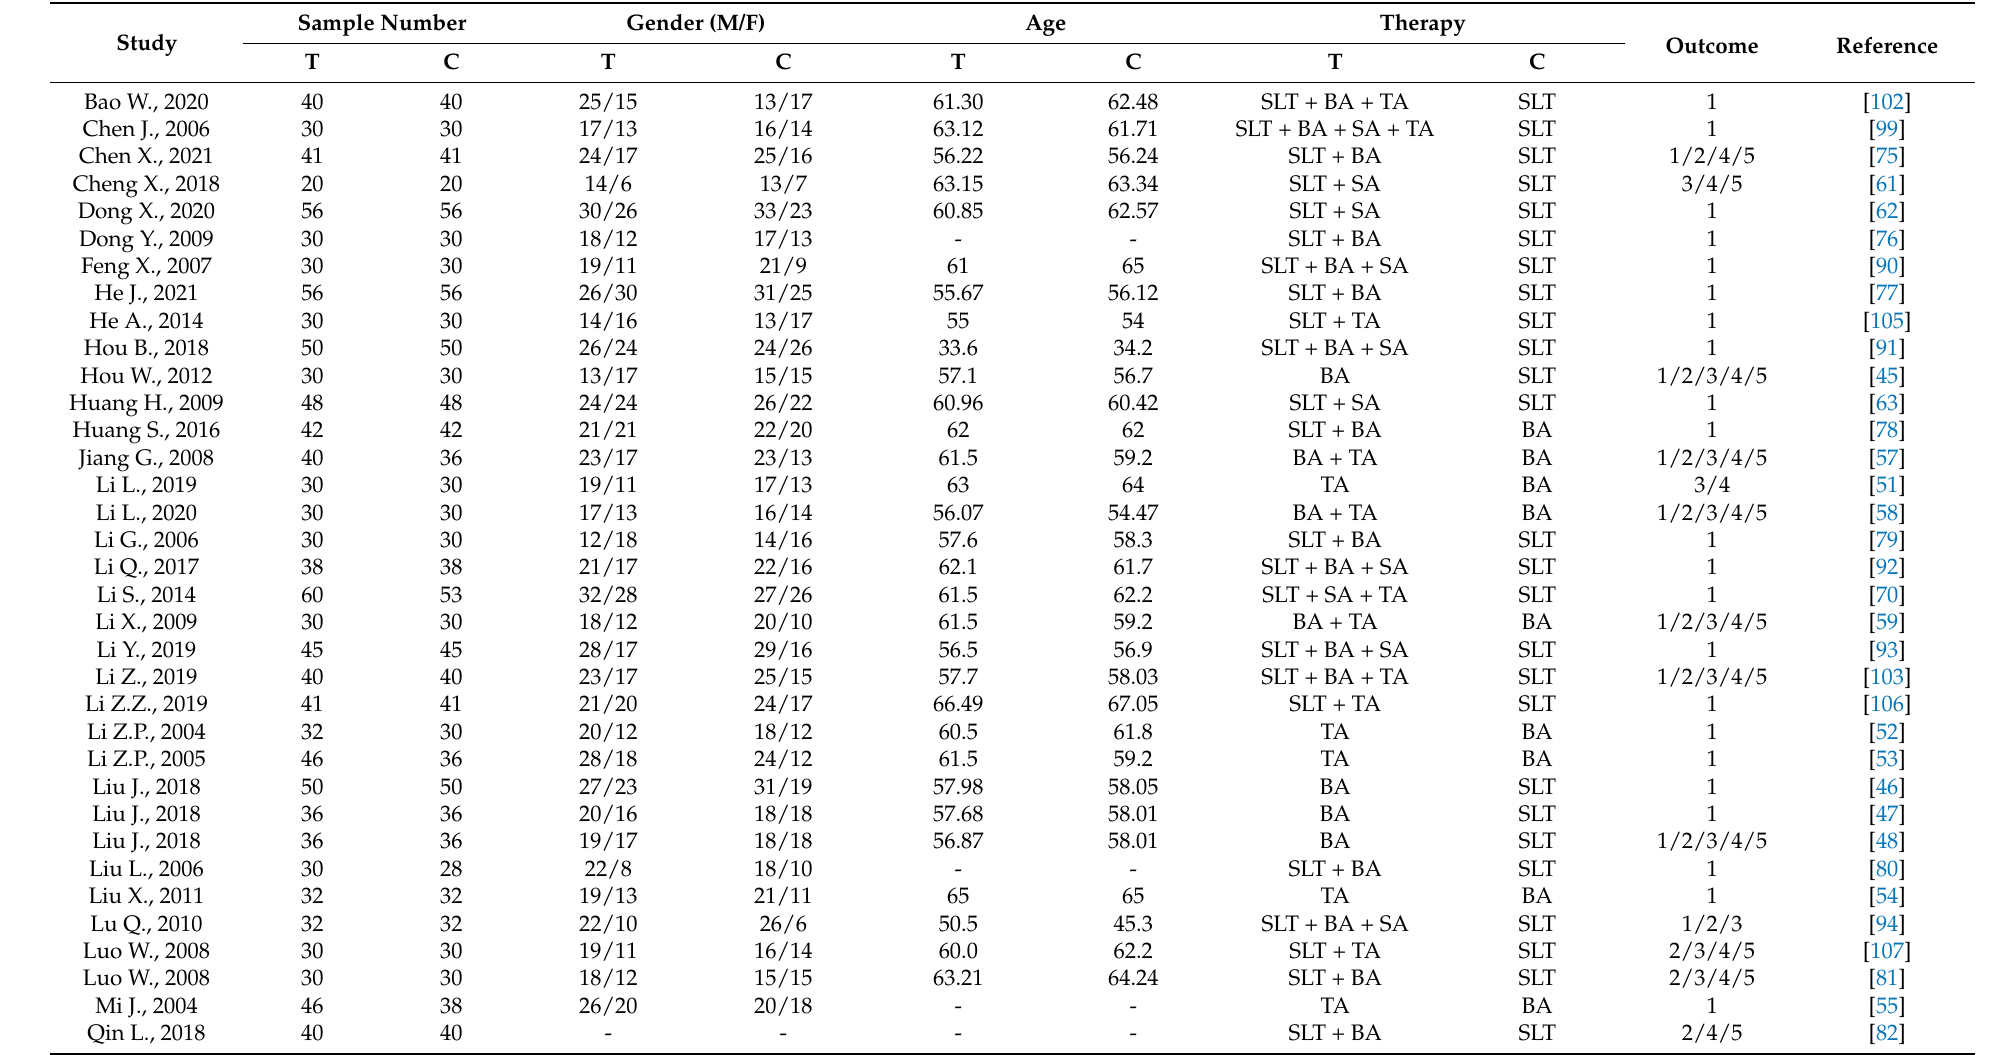
Table 1. Characteristics of the included